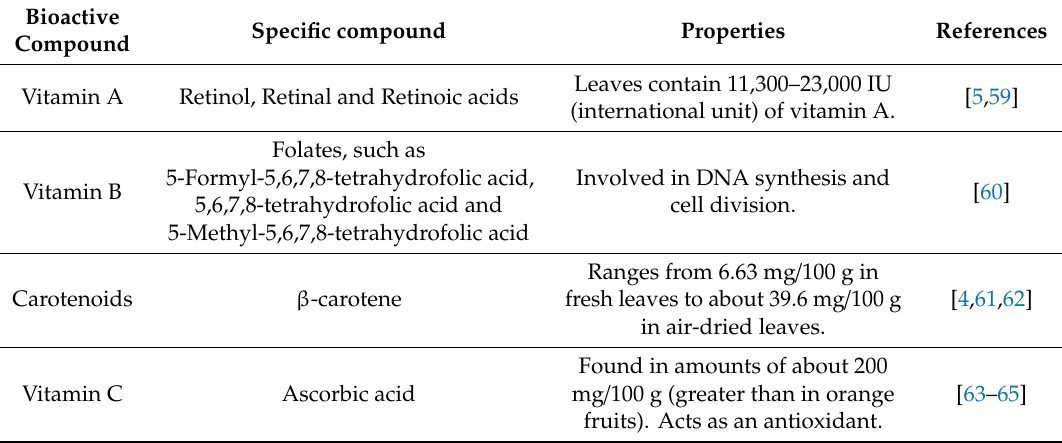
Table 1. Properties of vitamins and minerals found in Moringa oleifera